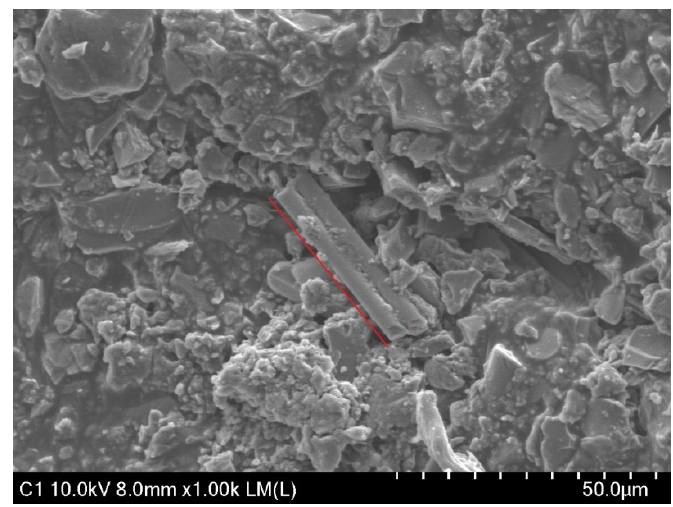
Figure 12. ( a ) Glass wool fibers mixed with asphalt binder and ( b ) asphalt concrete (AC) mixture with reinforced fibers .